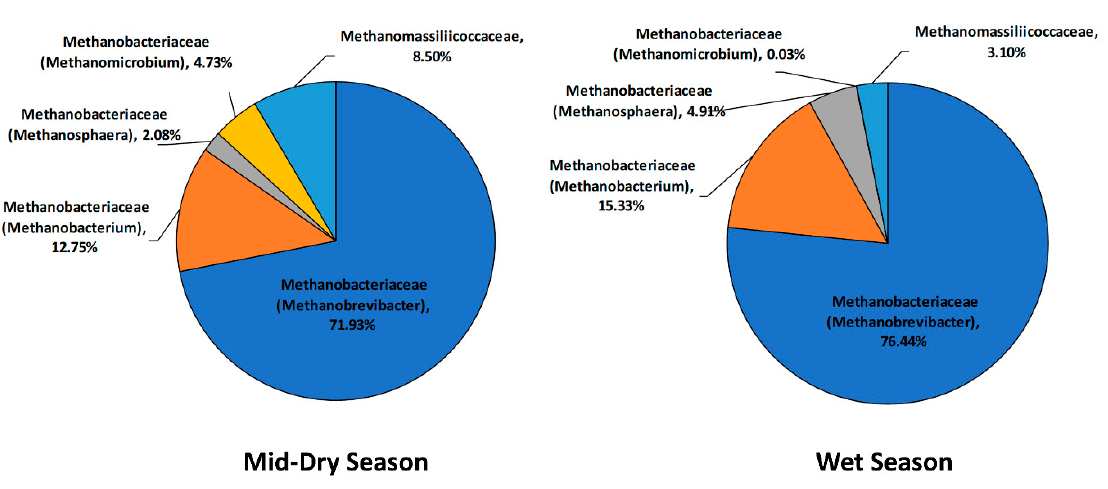
Figure 2. Taxonomic composition of the rumen bacteria community at the phylum level ( A ) and family level ( B ) for the mid-dry and wet seasons in un-supplemented animals.